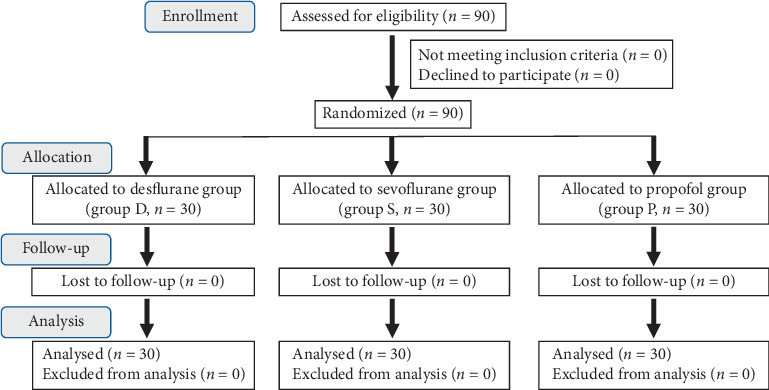
The CONSORT diagram.